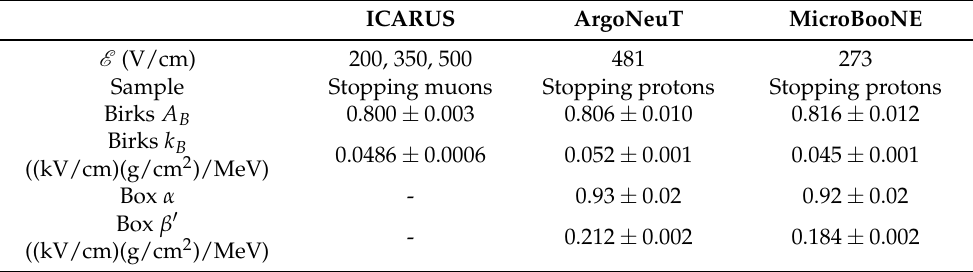
Table 2. The Birks and modified Box model parameters measured by the ICARUS, ArgoNeuT, and MicroBooNE